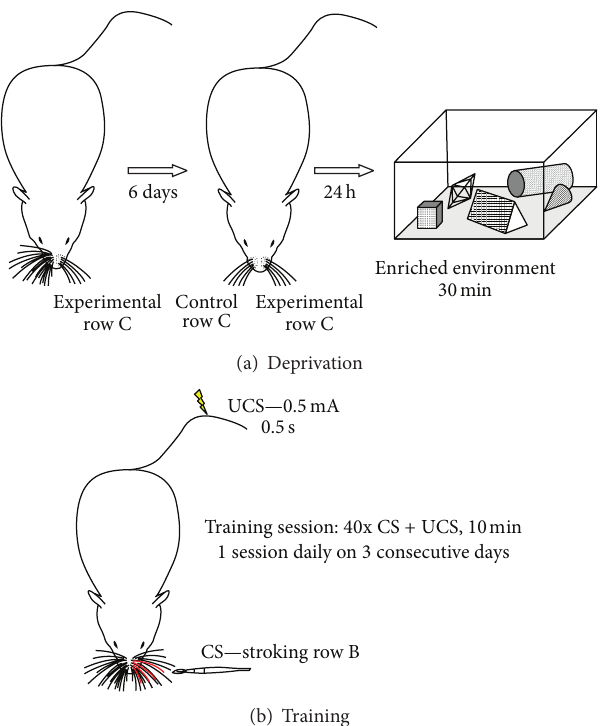
Figure 1: (a) Scheme of the deprivation procedure. All whiskers on one side of the snout except for row C are removed. After 6 days the same deprivation procedure is applied to the other side of the snout and the mouse is left with both C rows intact. After 24 h the animal explores a stimulatory cage for 30 minutes and is then immediately killed. (b) Scheme of the training procedure. Row B of whiskers on the left side of the snout is stroked (CS). The CS lasts for 9 s. During the last second an electric shock (0.5mA for 0.5 s, UCS) is delivered and coterminates with the CS. A single training session lasts for 10 minutes and encompasses 40 CS and UCS pairings. The animal is subjected to one session daily for three consecutive days. Following the last training session, the mouse is placed in its home cage for 20 minutes to allow increase in Npas4 expression and is then